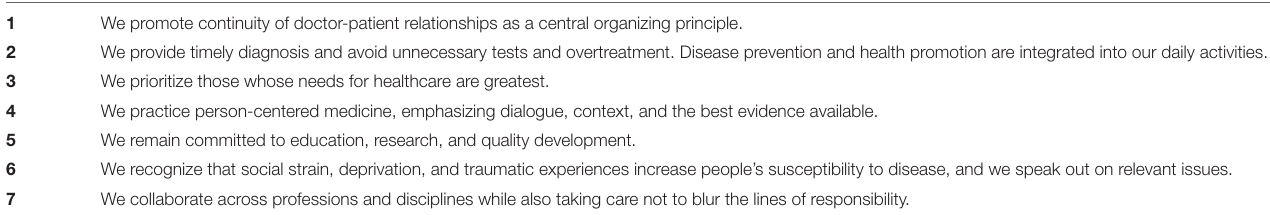
TABLE 1 | Core Values and Principles of Nordic General Practice/Family Medicine * .